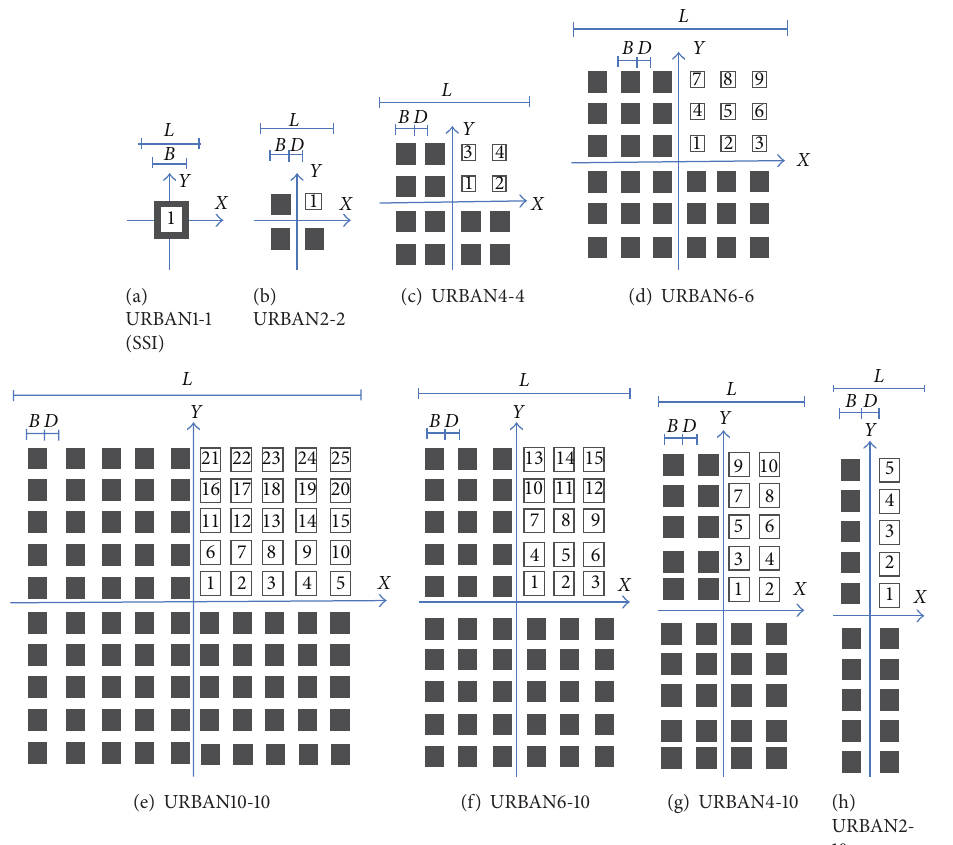
Figure 2: Arrangement of the structural groups.